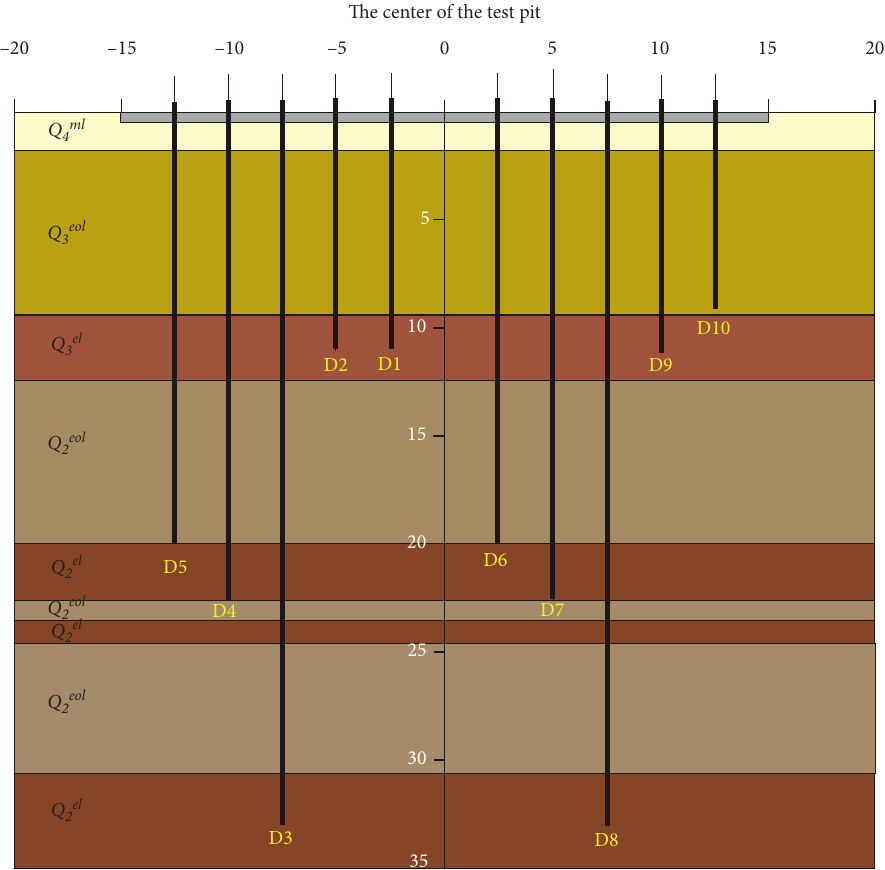
Figure 2: Geological profile of the test site (survey lines IV and